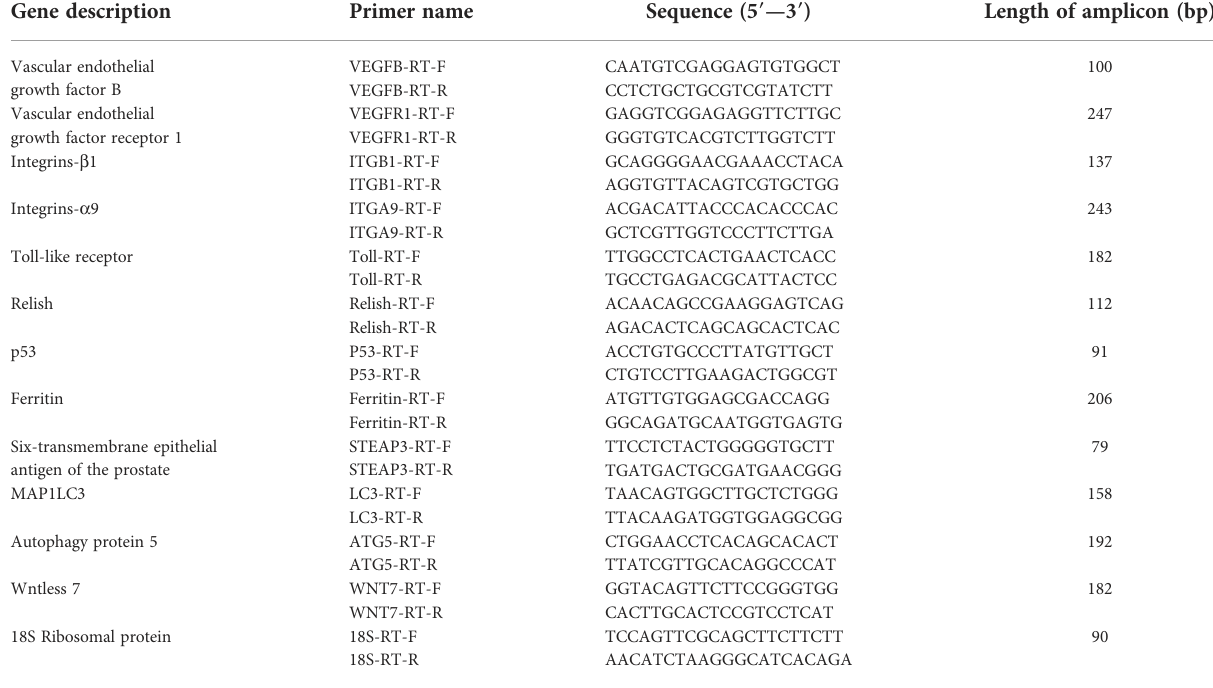
TABLE 1 Primer sequences used in this